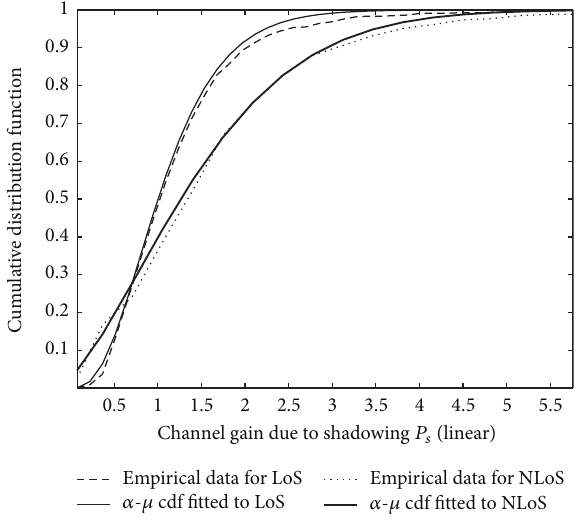
Figure 8: The empirical and fitted cdfs of multipath fading in the LoS and NLoS